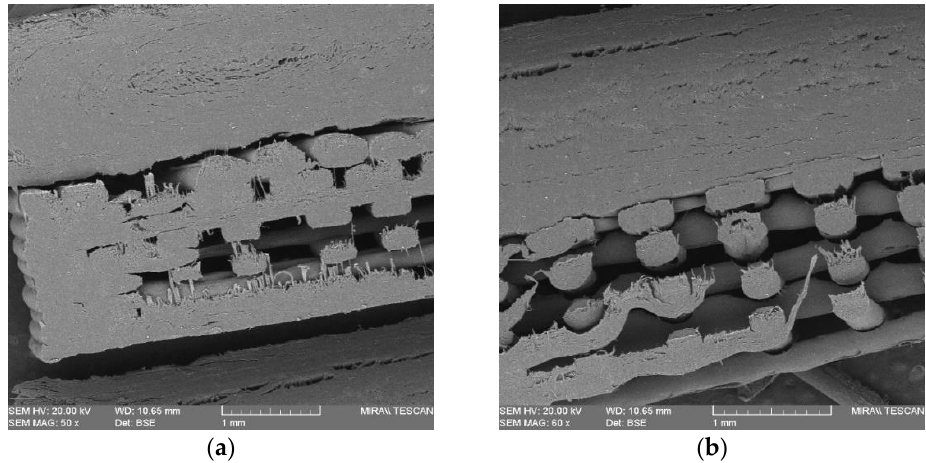
Figure 11. SEM scans of the cross-section of overprinted tablets: ( a ) 50% infill density with 6 solid layers; ( b ) 50% infill density with no solid layers.